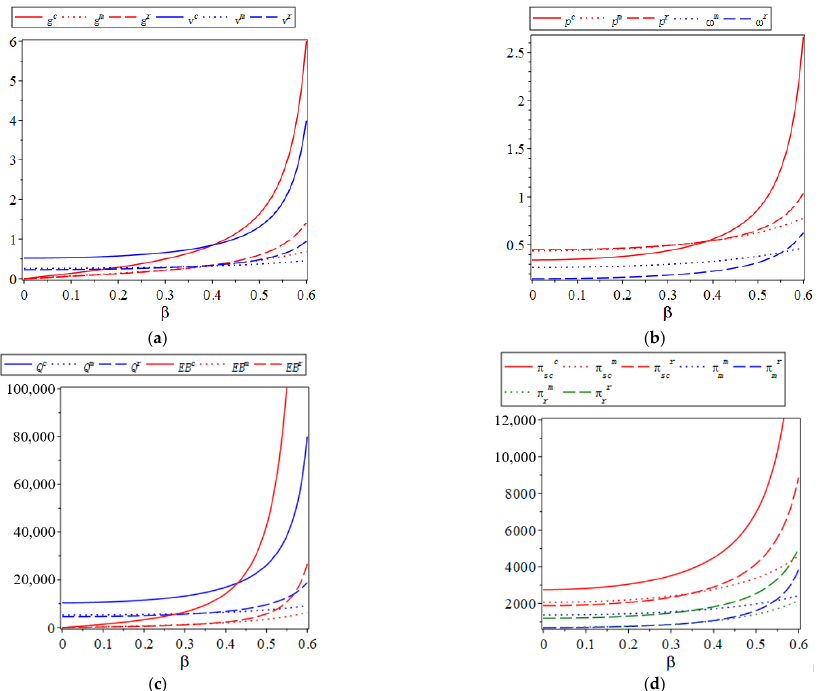
Figure 3. Decisions, demand, profits, and environmental benefit change with 𝛽 . ( a ) Greenness and targeted advertising intensity change with 𝛽 . ( b ) Prices change with 𝛽 . ( c ) Demand and environmental benefit change with 𝛽 . ( d ) Profits change with 𝛽 .